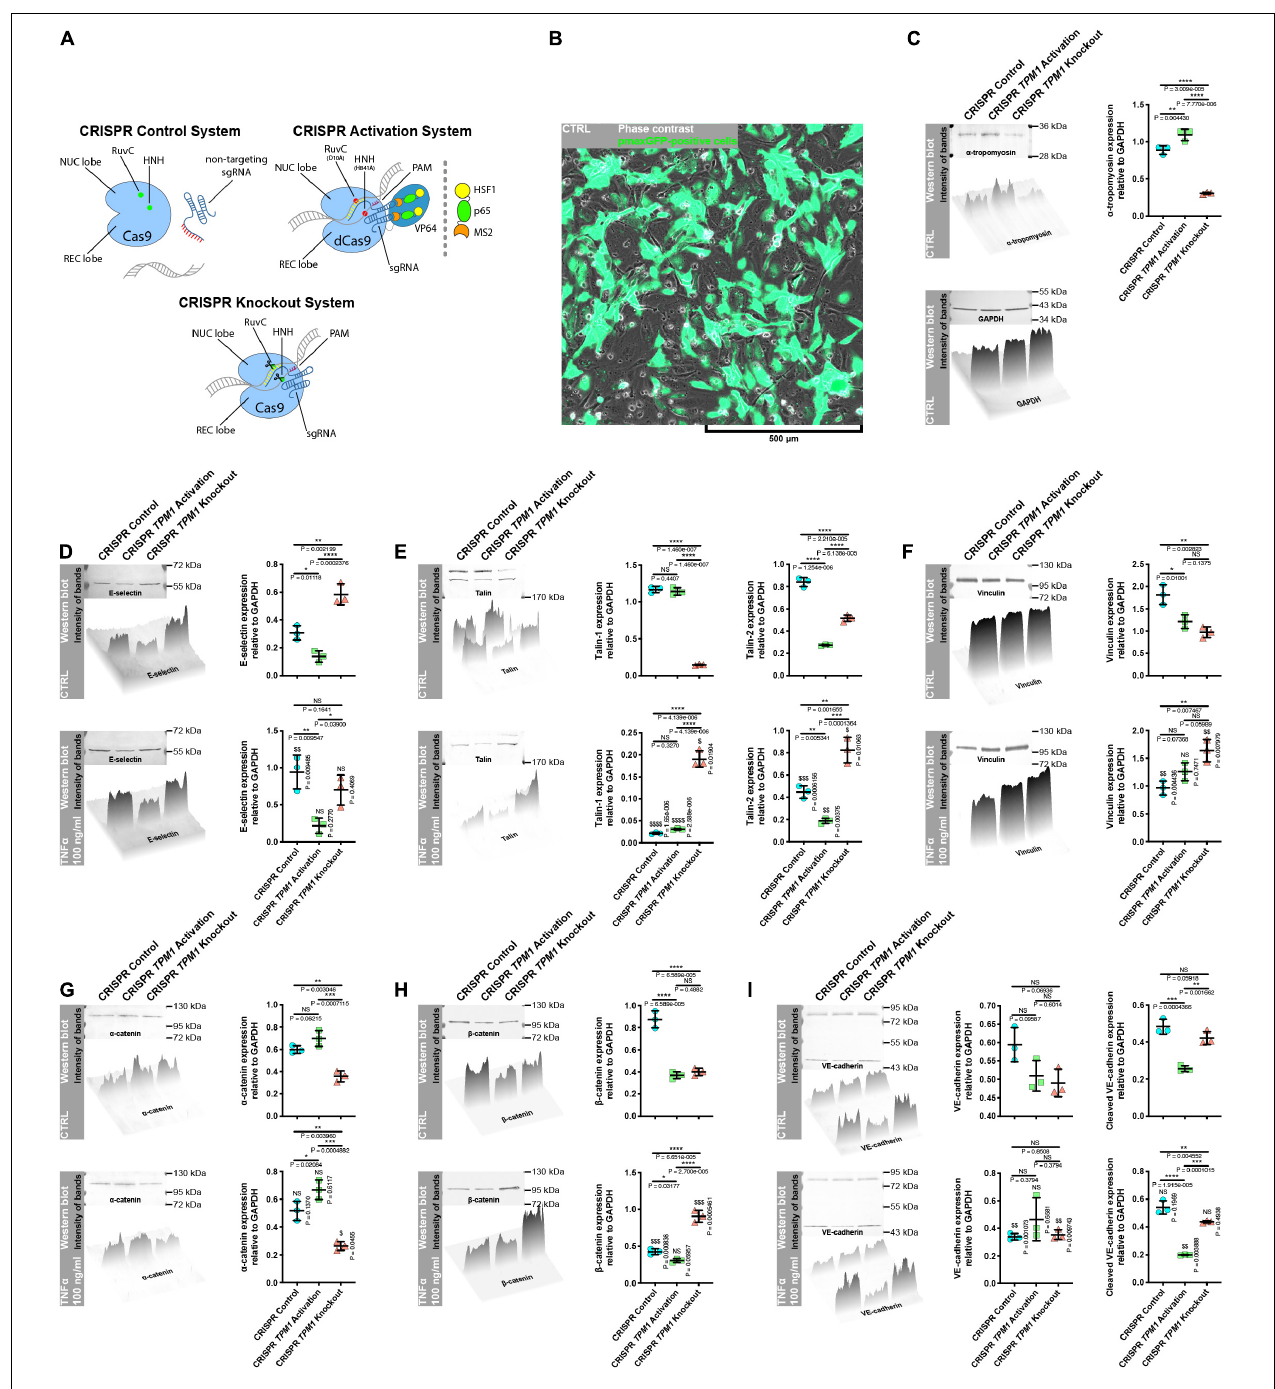
FIGURE 6 | Effect of TNF α on posttranslational expression of cell–cell and cell–ECM junctional proteins in pHCAECs with CRISPR-based modulated expression of TPM1 . (A) Schematic overview of CRISPR systems used in regulation of TPM1 expression in pHCAECs. The cells were nucleofected with a CRISPR control plasmid encoding the Cas9 nuclease and a non-specific guide RNA (upper left panel), CRISPR TPM1 activation system encoding the nuclease-deficient dCas9 fused to the transactivation domain VP64, a plasmid encoding the MS2-p65-HSF1 fusion protein, and a guide RNA targeting sequences upstream of the TPM1 transcriptional start site (upper left panel) or CRISPR TPM1 -knockout system encoding the Cas9 nuclease and a TPM1 -specific 20-nt guide RNA (lower panel). (B) Representative micrograph of intravital detection of pmaxGFP plasmid product (green fluorescence) in nucleofected pHCAECs (contrast phase). (C) Representative western blots, surface plot, and densitometric analysis for α -tropomyosin (upper panel) and GAPDH (lower panel). CTRL refers to the control, ** to p < 0.01, **** to p < 0.0001. (D) Representative western blots, surface plot, and densitometric analysis for E-selectin. CTRL refers to the control (upper panel), TNF α 100 ng/ml to cells treated with rh TNF α (lower panel), NS to non-significant, * to p < 0.05, ** to p < 0.01, **** p < 0.0001, as determined by the Kruskal–Wallis test, $$ to p < 0.01, as